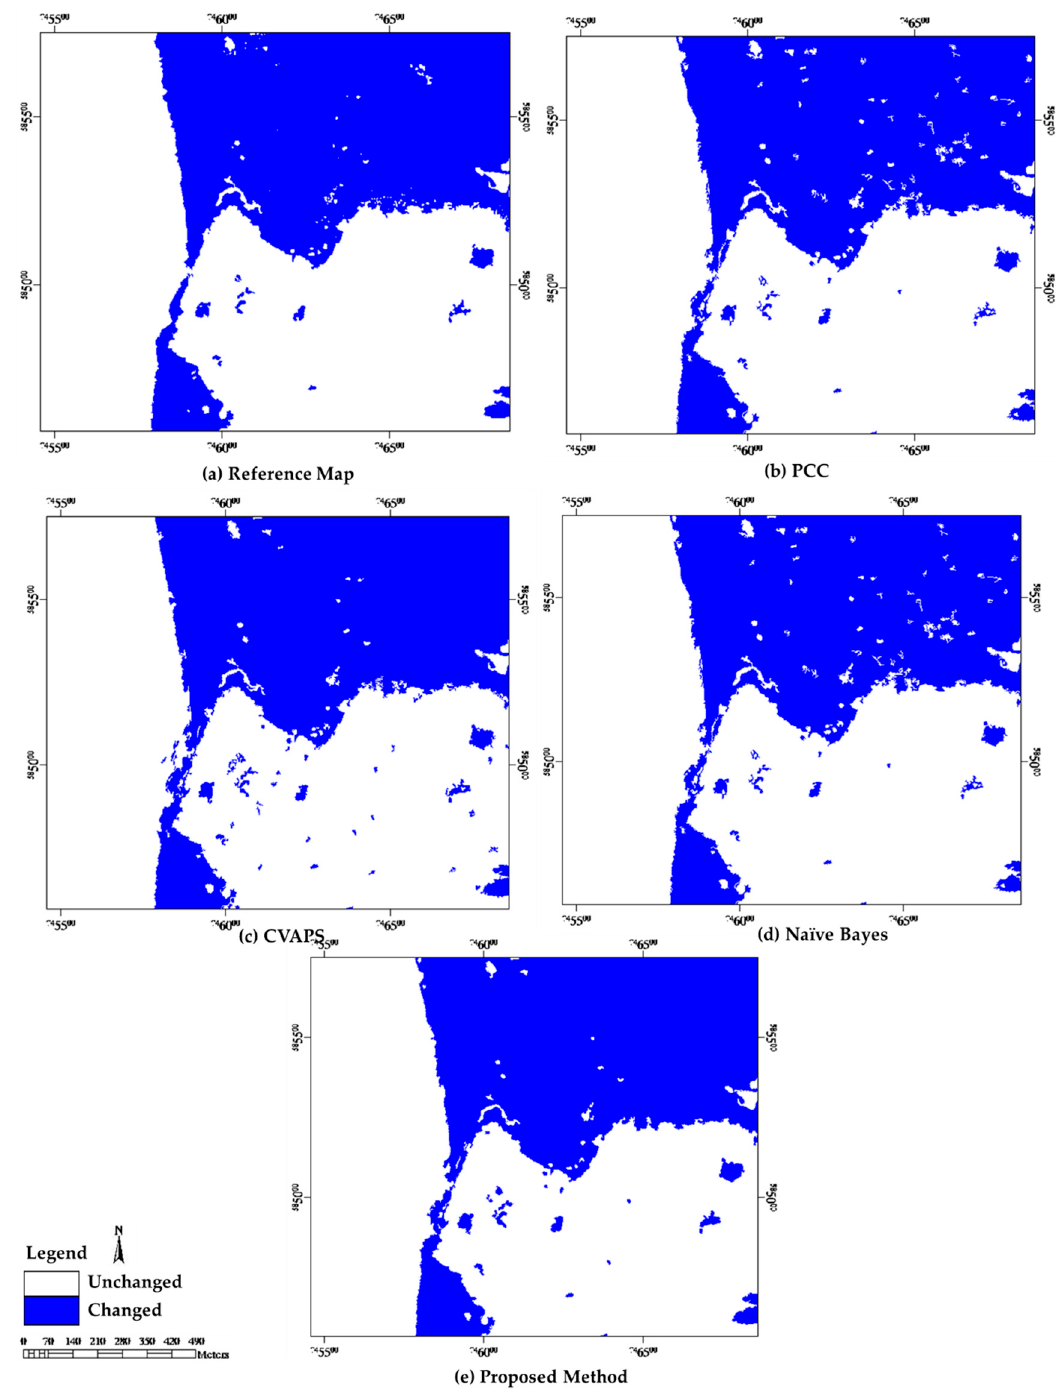
Figure 9. Change maps for the Experiment II data set.